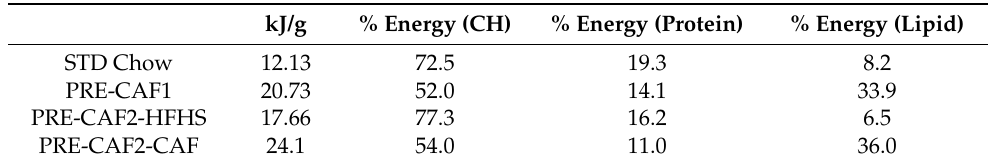
Figure 1. Schematic diagram of the experimental design. CAF: cafeteria diet; (1) PRE-CAF1: rats receiving GSPE (Grape-seed proanthocyanidins) preventive treatment 10 days before the cafeteria intervention started; (2) PRE-CAF2: rats receiving GSPE preventive treatment for 10 days together with a high fat/high sucrose diet followed by the cafeteria diet intervention; (3) SIT-CAF: rats receiving GSPE treatment simultaneously and intermittently with the cafeteria diet every other week; (4) CORR-CAF: rats receiving GSPE corrective treatment during the last 15 days of the cafeteria intervention. GSPE: grape seed proanthocyanidin extract; NMR: nuclear magnetic resonance; OGTT: oral glucose tolerance test; Ind. Cal.: Indirect calorimetry; WATs: white adipose tissues. Table 1. Composition of meals